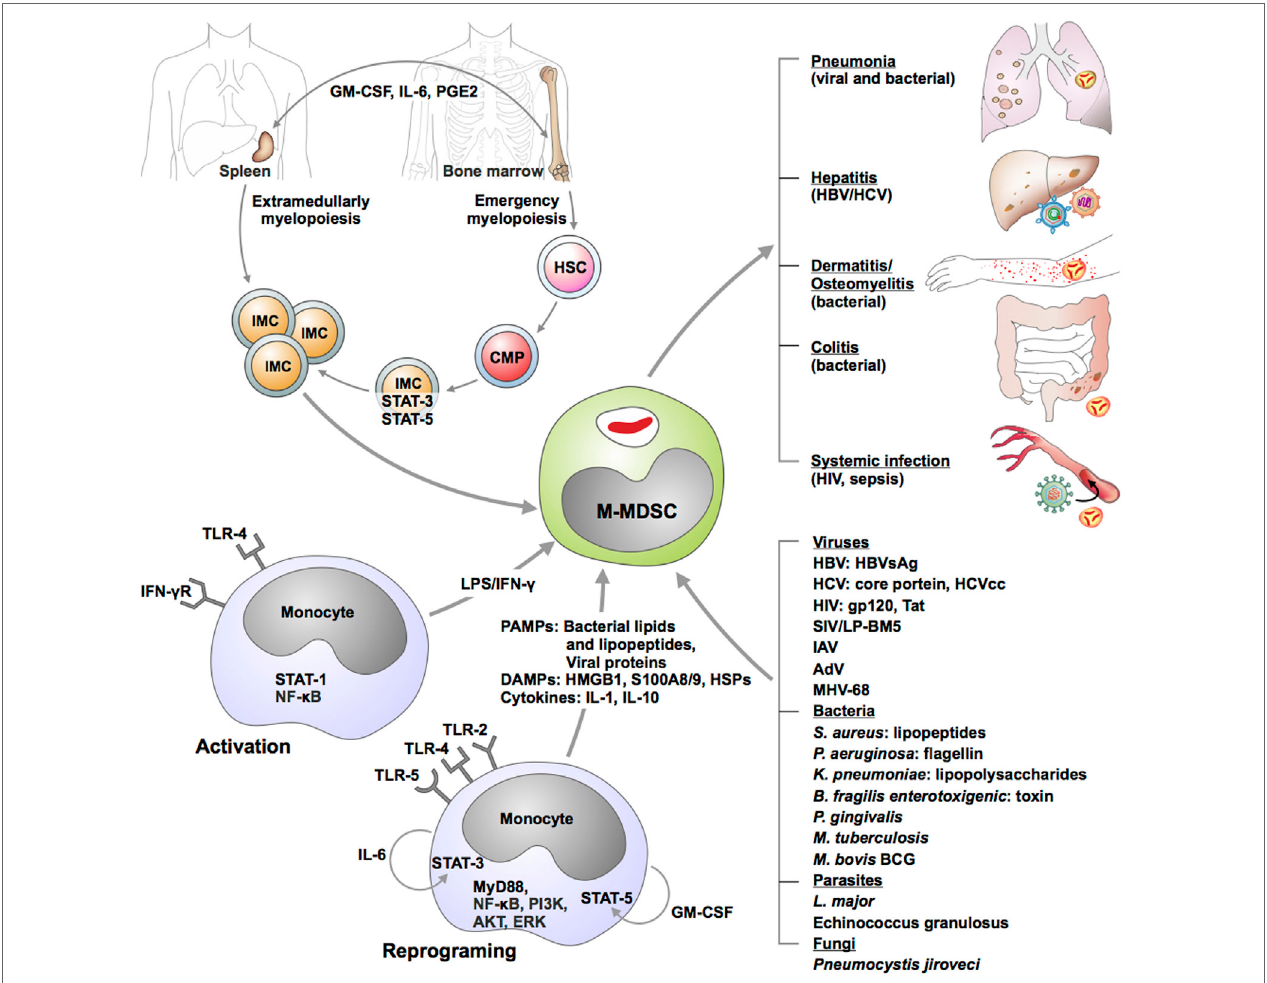
FiGURe 1 | Genesis of monocytic myeloid-derived suppressor cells (M-MDSC) during infectious diseases. Hypothetical models were derived from ex vivo results, correlative studies in animal models as well as clinical observations. Immature myeloid cells (IMC) are generated either in bone marrow or in spleen as a consequence of emergency myelopoiesis. Growth factors, cytokines, and lipids promote progression of hematopoietic stem cells (HSC) toward common myeloid progenitor (CMP) development and subsequent IMC genesis. Combination of cytokines as well as direct stimulation of selected microbial receptors by various microorganisms may activate or reprogram circulating monocytes toward M-MDSC. M-MDSC are recruited in various organs where they exert suppressive function and modulate manifestations and outcome of the disease. Abbreviations: AdV, adenovirus; AKT, protein kinase B; ERK, extracellular signal-regulated kinase; GM-CSF, granulocyte-macrophage colony stimulating factor; gp120, glycoprotein 120; HBV, hepatitis B virus; HBVsAg, HBV soluble antigen; HCV, hepatitis C virus; HIV, human immunodeficiency virus; IAV, influenza A virus; IFN- γ , interferon gamma; IL-6, interleukin 6; LPS, lipopolysaccharide; LP-BM5, virus murine acquired- immune deficiency syndrome (AIDS); MHV-68, murine herpesvirus 68; MyD88, myeloid differentiation primary response gene 88; NF- κ B, nuclear factor “kappa-light- chain-enhancer” of activated B-cells; PI3K, phosphatidylinositide 3-kinase; PGE2, prostaglandin E2; STAT, signal transducer and activator of transcription; SIV, simian immunodeficiency virus; tat, trans-activator of transcription; TLR, toll-like